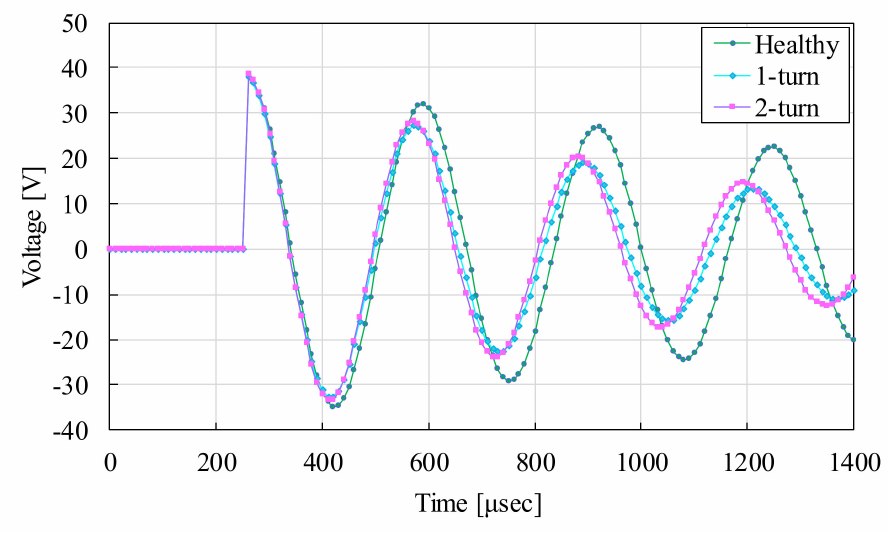
Figure 7. Voltage waveforms across U–V terminals obtained for healthy, one-turn SCF, and two-turn SCF